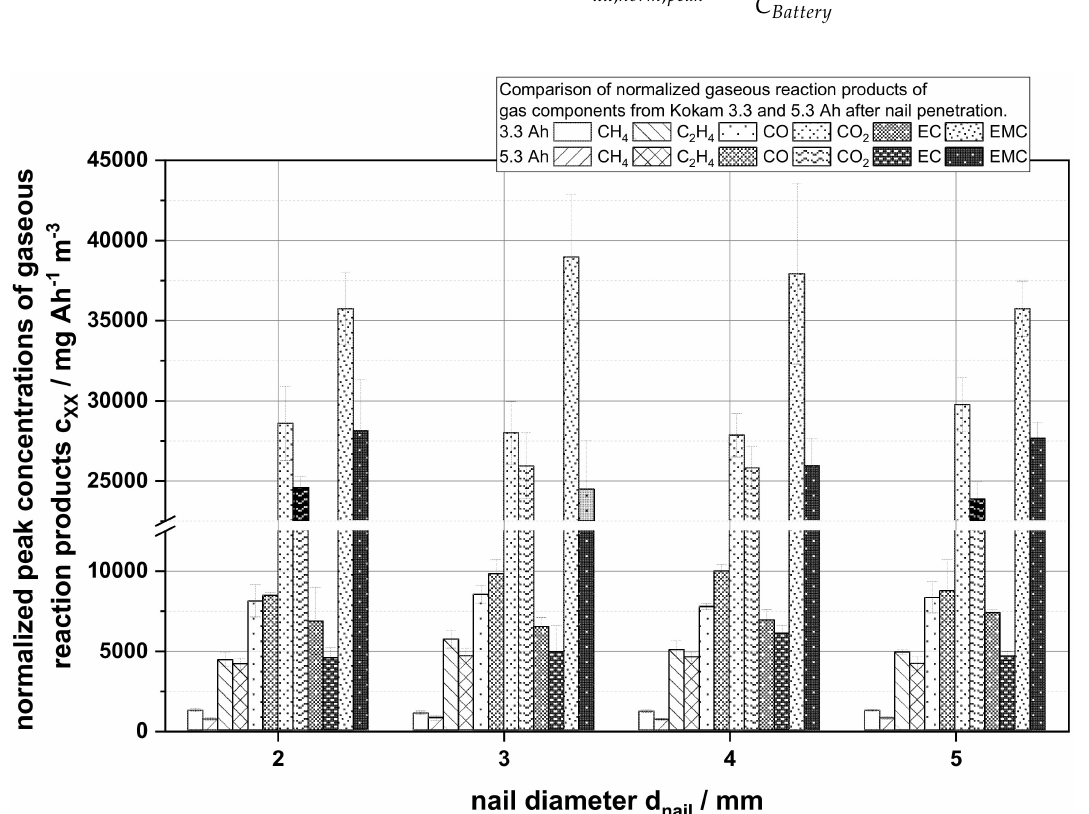
Figure 6. Comparison of the normalized measured peak gas concentrations c xx in mg Ah − 1 m − 3 in dependency of the nail diameter of the gases CH 4 , C 2 H 4 , CO, CO 2 , EC and EMC as a part of the main reactions components from the thermal